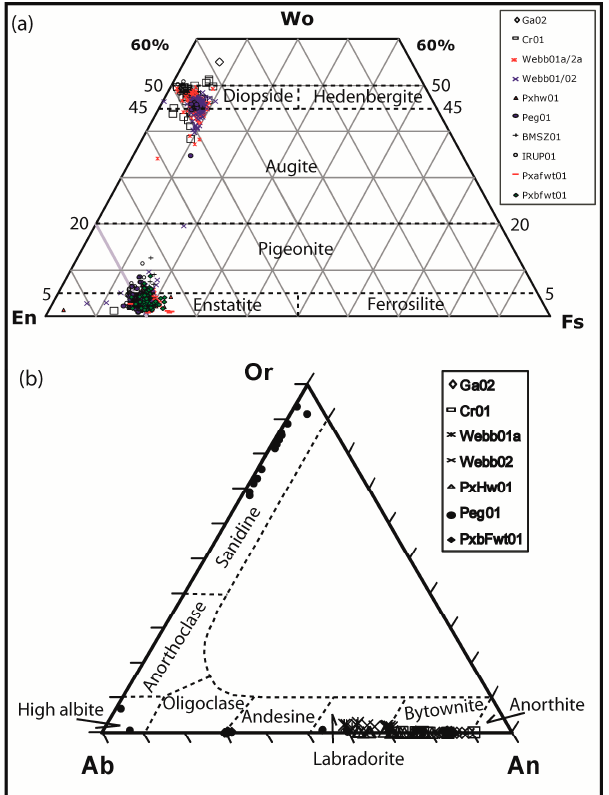
Figure 12. ( a ) Composition of both orthopyroxenes and clinopyroxenes from the MSZ which fall into the enstatite, pigeonite, augite and diopside fields. Classification of pyroxenes after Deer et al. (1992) [67]. ( b ) Composition of both plagioclase and potassium feldspars from the MSZ. Table 4. Representative clinopyroxene analyses in wt. %.